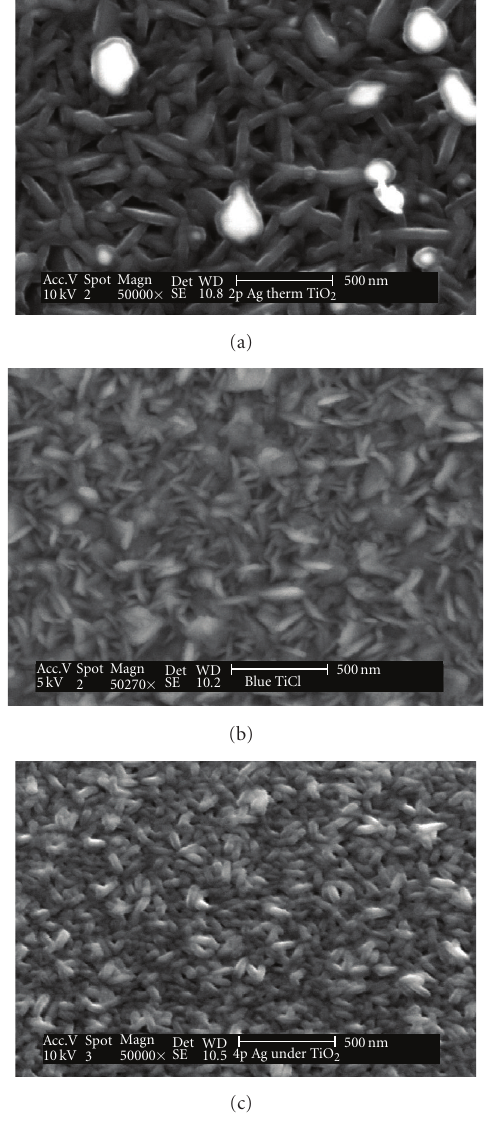
Figure 5: SEM images of (a) Ag(2) on top of TiO 2 , (b) TiO 2 on barrier glass, (c) TiO 2 (TTIP) over Ag (4 passes).